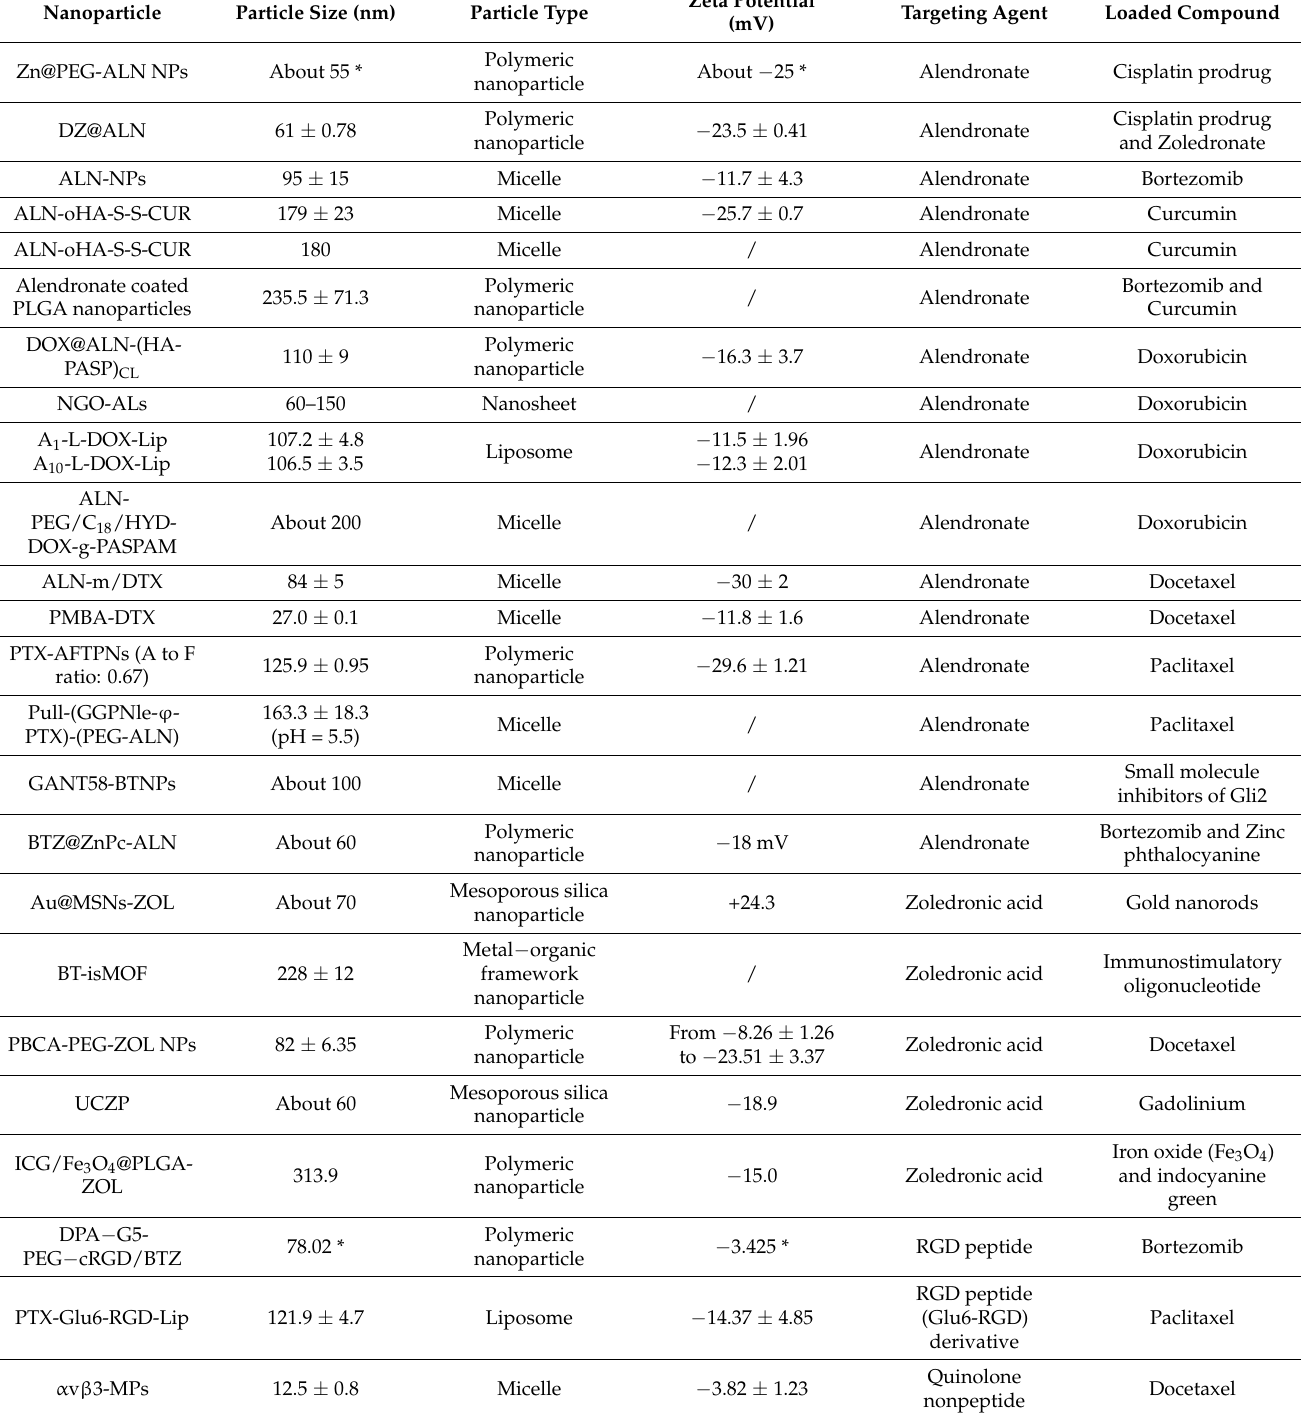
Table 3. A summary of targeted therapeutics for BC bone